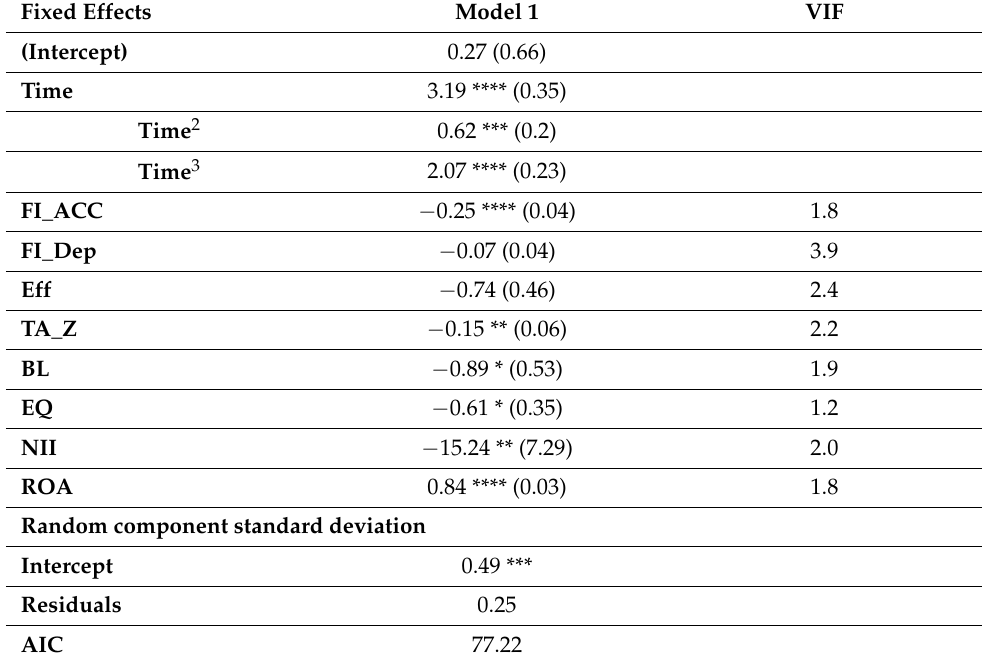
Table 5. Linear Mixed Model baseline